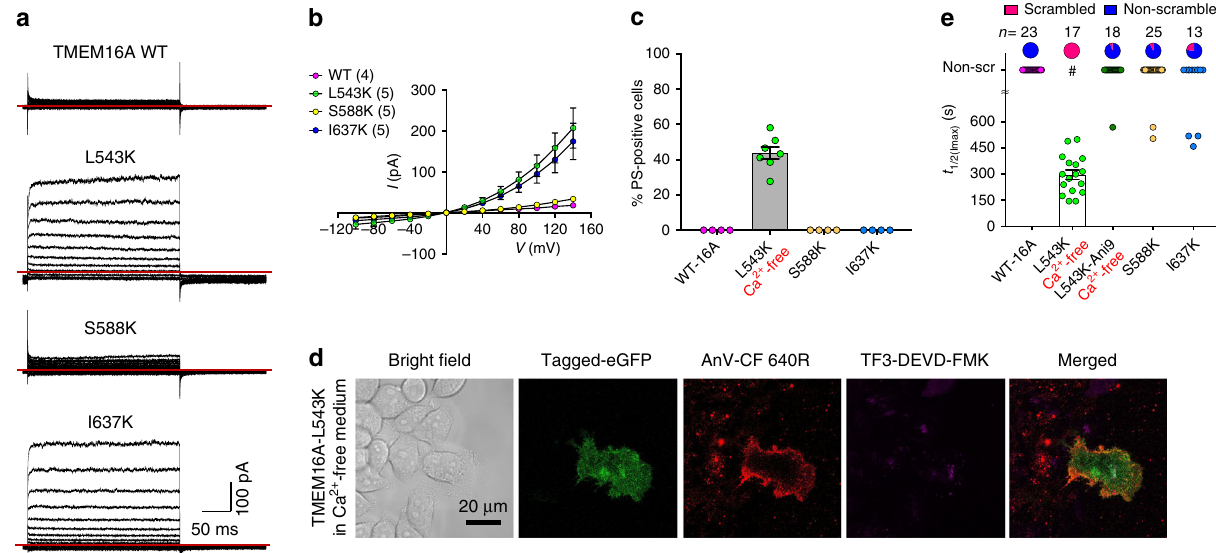
Fig. 6 A Lysine mutation at TMEM16A inner gate converts the CaCC into a CaPLSase. a Representative current traces of inside-out patches excised from TMEM16A-WT or mutations-expressing HEK293T cells in the absence of intracellular Ca 2 + . Testing potentials were from − 100 mV to + 140 mV with 20 mV increments. Both holding and repolarizing potentials were − 60 mV. b Current – voltage ( I – V ) relationship of the equivalent inner gate mutations in TMEM16A. Error bars indicate SEM. c L543K-TMEM16A expression induced spontaneous PS exposure (in the absence of ionomycin treatment) even when cultured in Ca 2 + -free medium (#). Each dot represents the percentage of PS-positive cells over the total expressing cells (WT-TMEM16A or mutants) of one coverslip. d Representative images of eGFP-tagged L543K-TMEM16A-expressing cells without ionomycin stimulation. AnV-CF 640R-labeled PS- positive cells. Weak TF3-DEVD-FMK staining of cleaved caspases 3/7 suggests that the cells were not apoptotic. e Ionomycin-induced CaPLSase activity for wild type (WT) and the mutant TMEM16A quanti fi ed by t 1/2(Imax) . Treatment with 10 µ M Ani9 inhibits TMEM16A-L54K scrambling activity as indicated by its t 1/2(Imax) . Each dot represents one cell and n is the total number of cells measured. The pie charts illustrated the percentages of ionomycin-induced scrambling cells and non-scr denotes non-scrambling and are excluded from statistical analysis. As a majority of TMEM16A-WT, -L543K (Ani9), S588K, and I637K expressing cells do not scramble, mean and SEM are not assigned for those mutations. Error bars indicate SEM. All imaging experiments were done in the TMEM16F-knockout HEK293T cells. All of the experiments based on AnV labeling were done in Ca 2 + -containing buffer. Scale bars, 25 µ m.